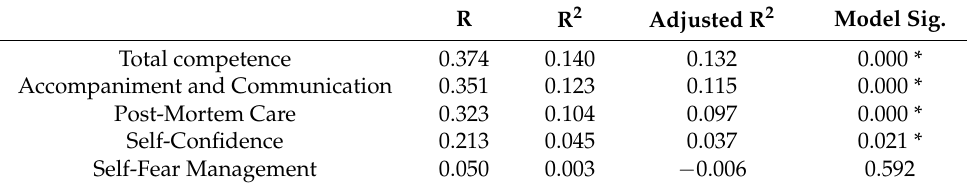
Table 6. Influence of first-year scores on fourth-year scores. R R 2 Model Sig. Accompaniment and Communication